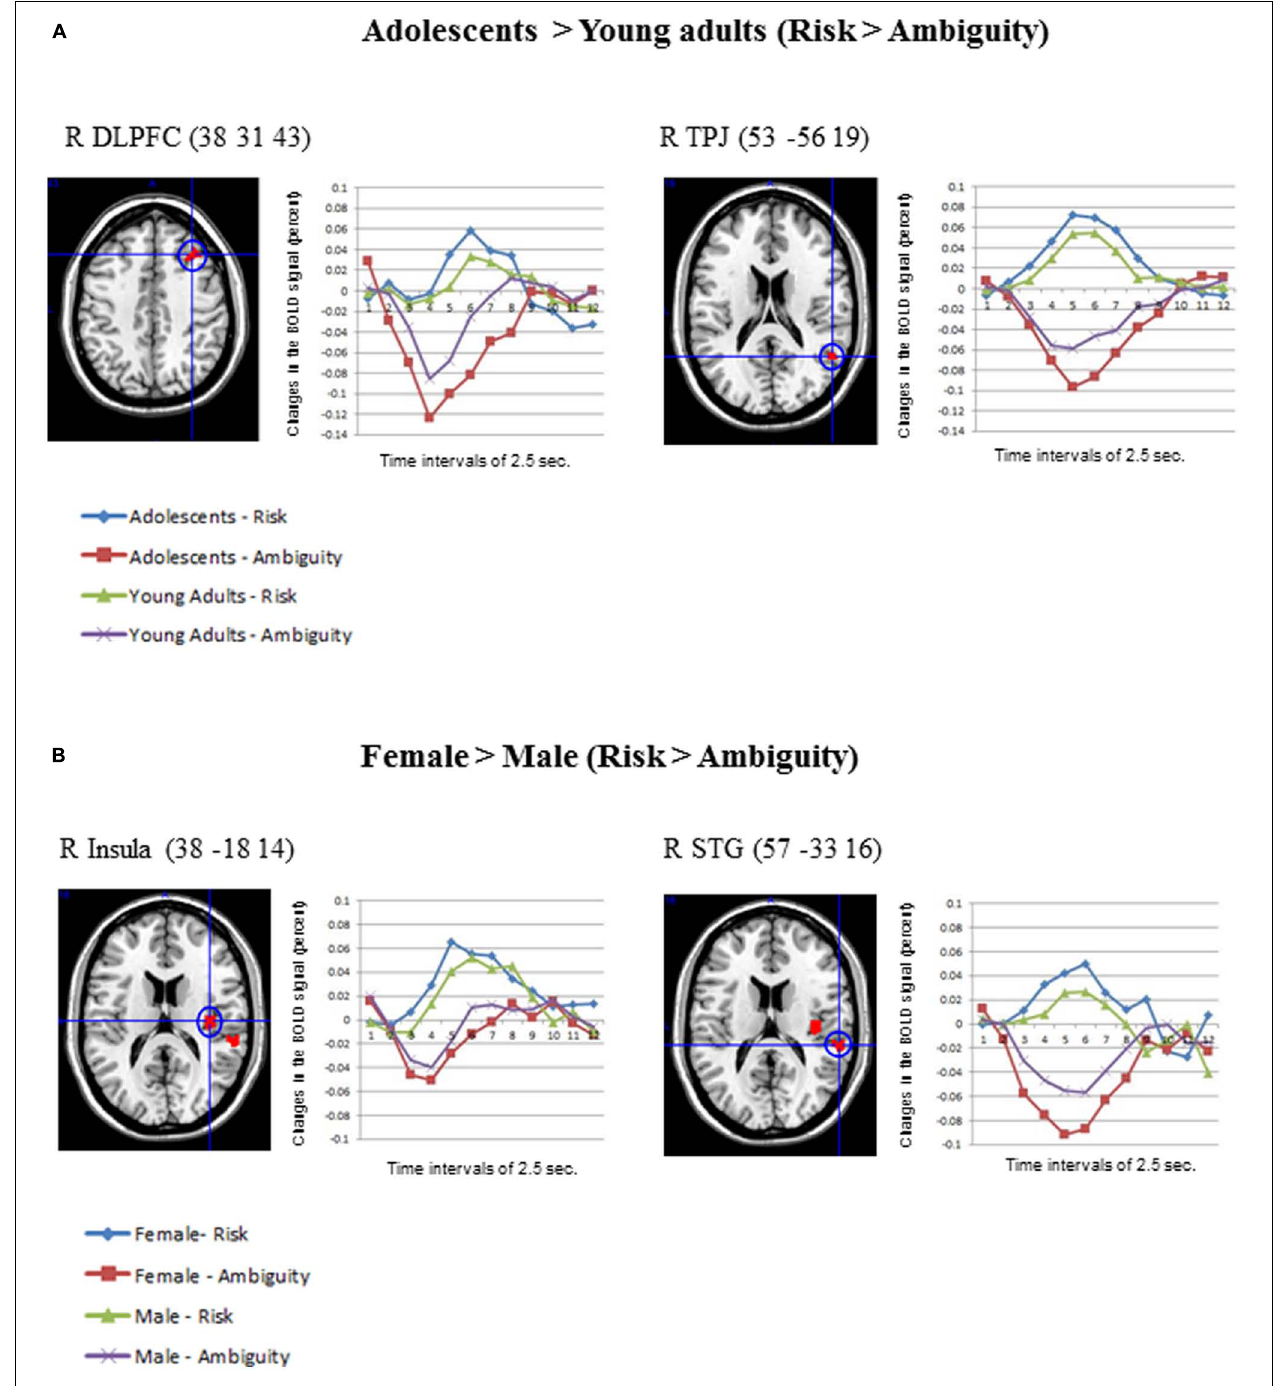
in the contrast Risk > Ambiguity , produced two clusters in the right insula and the superior temporal gyrus. Also the changes in the BOLD signal across time are shown for these regions in each gender group, using time intervals of 2.5 s. Age and gender results were significant at an uncorrected threshold of p = 0.001, and K >